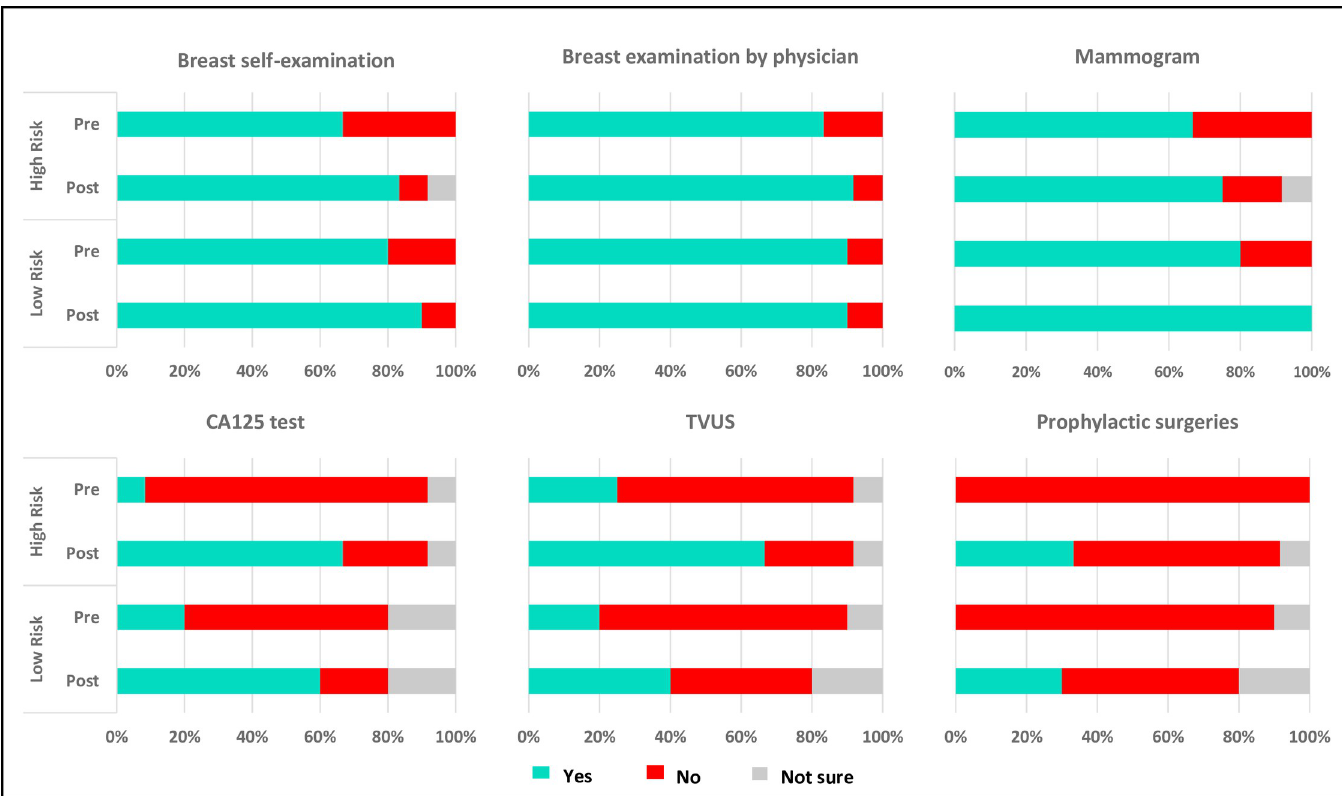
Fig 4. Utilisation (within the past 6 months prior to pre-questionnaire); intent (planning to carry out within the next 12 months after post-questionnaire) of screening and prophylactic surgery. High a priori risk carriers (N = 12) and Low a priori risk carriers (N = 10).